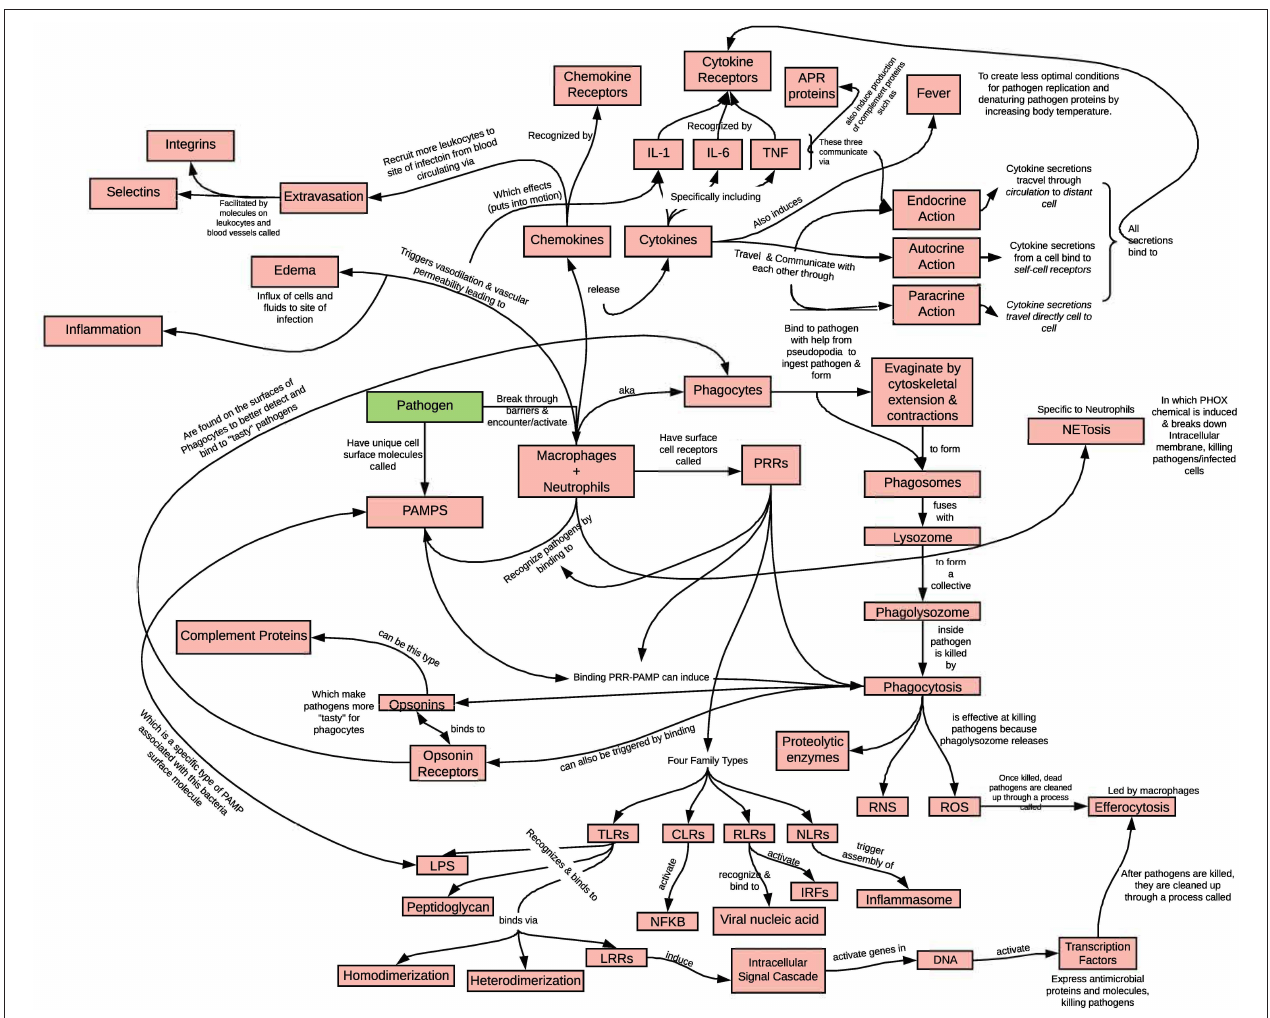
FIGURE 2 | Example of a group generated concept map. An example of a student concept map of innate immunity and inflammation, using the terms listed in Table 5 . At the end of each week of class, the instructor assigns a list of important terms from that week for students to concept map, working in groups. One such concept map developed by four students working outside of class is shown. Each boxed term was on the list of assigned terms. The instructor grades the map for accuracy and completion. Students generated this concept map using the Lucidchart program, which has free educational access and allows real-time collaboration between